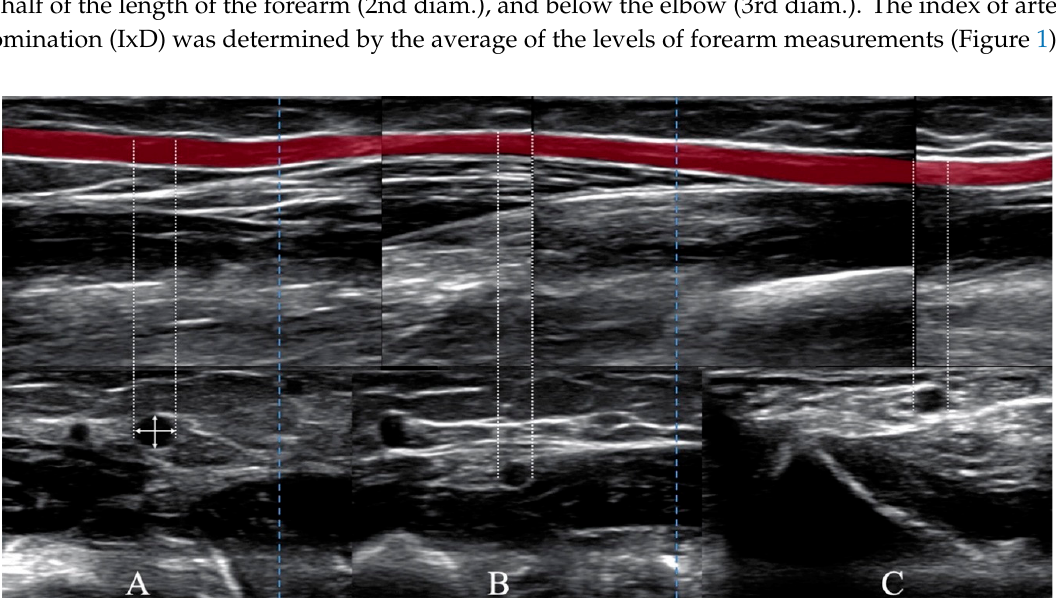
Figure 1. Diagram of radial artery diam. measurements. ( A ) elbow level, ( B ) ½ half forearm level, ( C ) wrist level, crossing arrows in (A)—scheme of measurements of diam. in the transverse projection of the radial artery.